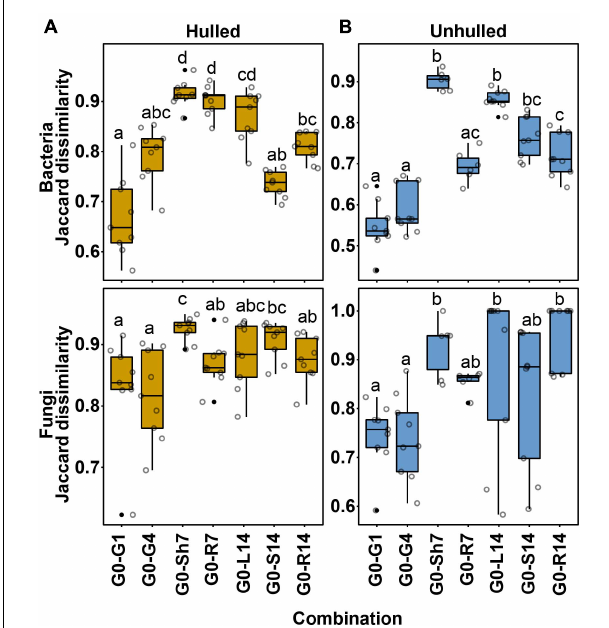
FIGURE 3 | Community dissimilarity between microbial communities before and after planting. (A) Community dissimilarity in bacterial and fungal communities between samples taken before and after planting under hulled conditions. (B) Community dissimilarity in bacterial and fungal communities between samples taken before and after planting under unhulled conditions. Community dissimilarity was calculated using the Jaccard dissimilarity index. In panels (A,B) , the upper and lower panels show bacterial and fungal communities, respectively. Dots on each box plot indicate dissimilarity values estimated through pairwise comparison among biological replicates. Letters indicate the statistical significance, estimated using the Kruskal–Wallis test followed by Dunn’s test. The results of the statistical analysis are available in Supplementary Table 4 . G0, seed microbial community before planting; G1, seed microbial community at 1 day after planting; G4, seed microbial community at 4 days after planting; Sh7, microbial community of the shoot endosphere at 7 days after planting; R7, microbial community of the root endosphere at 7 days after planting; L14, microbial community of the leaf endosphere at 14 days after planting; S14, microbial community of the stem endosphere at 14 days after planting; and R14, microbial community of the root endosphere at 14 days after